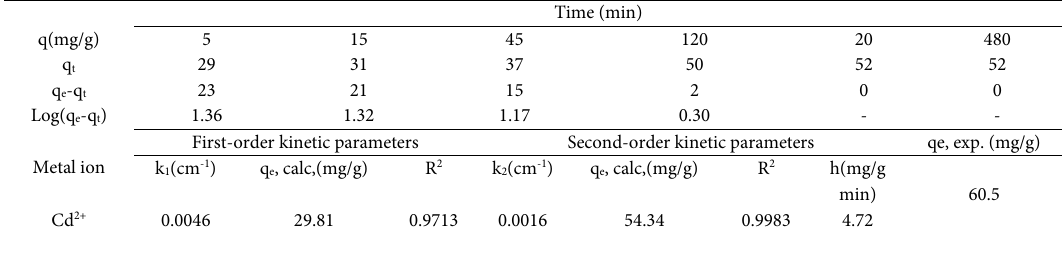
Table 2 Adsorption kinetic model rate constants for Cd(II) adsorption on nnatural zeolite. Table 2. Adsorption kinetic model rate constants for Cd(II) adsorption on nnatural